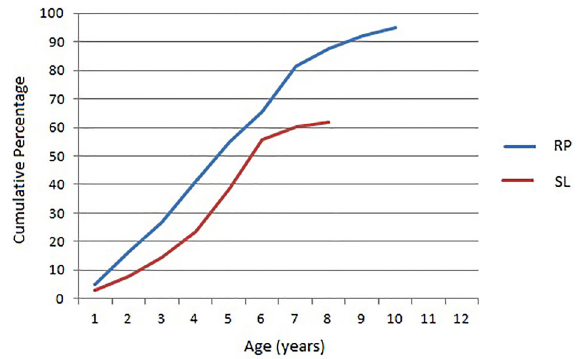
Figure 2. Cumulative distribution of age at fi rst dental visit in the Ribeirão Preto (RP) and São Luís (SL) cohorts (2004/2005). Lines do not add up to 100% because of censored data (those who had not seen a dentist by the time of